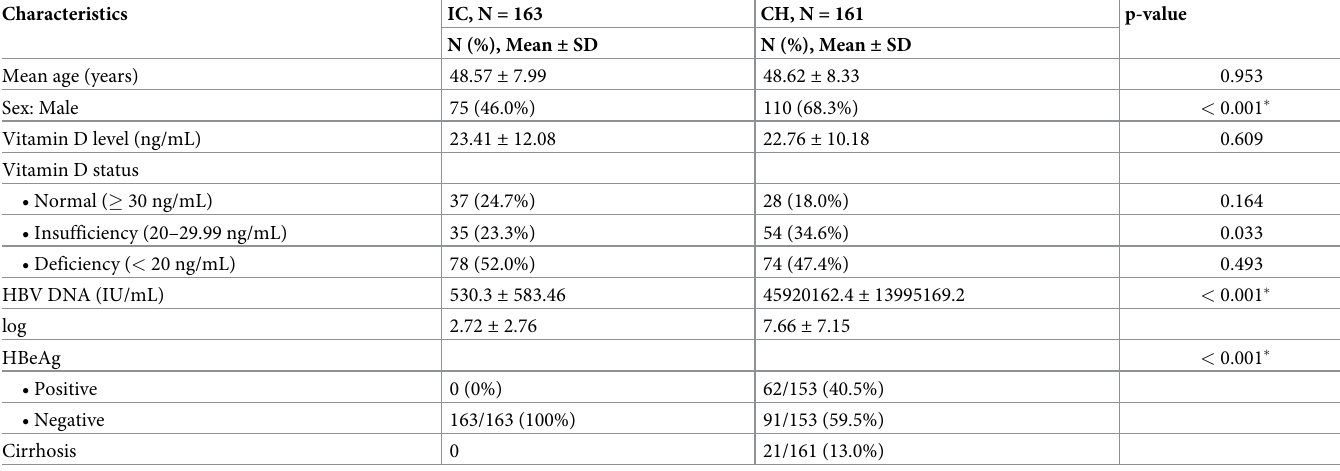
Table 1. Baseline characteristics of patients with HBV inactive carrier (IC) and chronic hepatitis (CH) phases. Characteristics